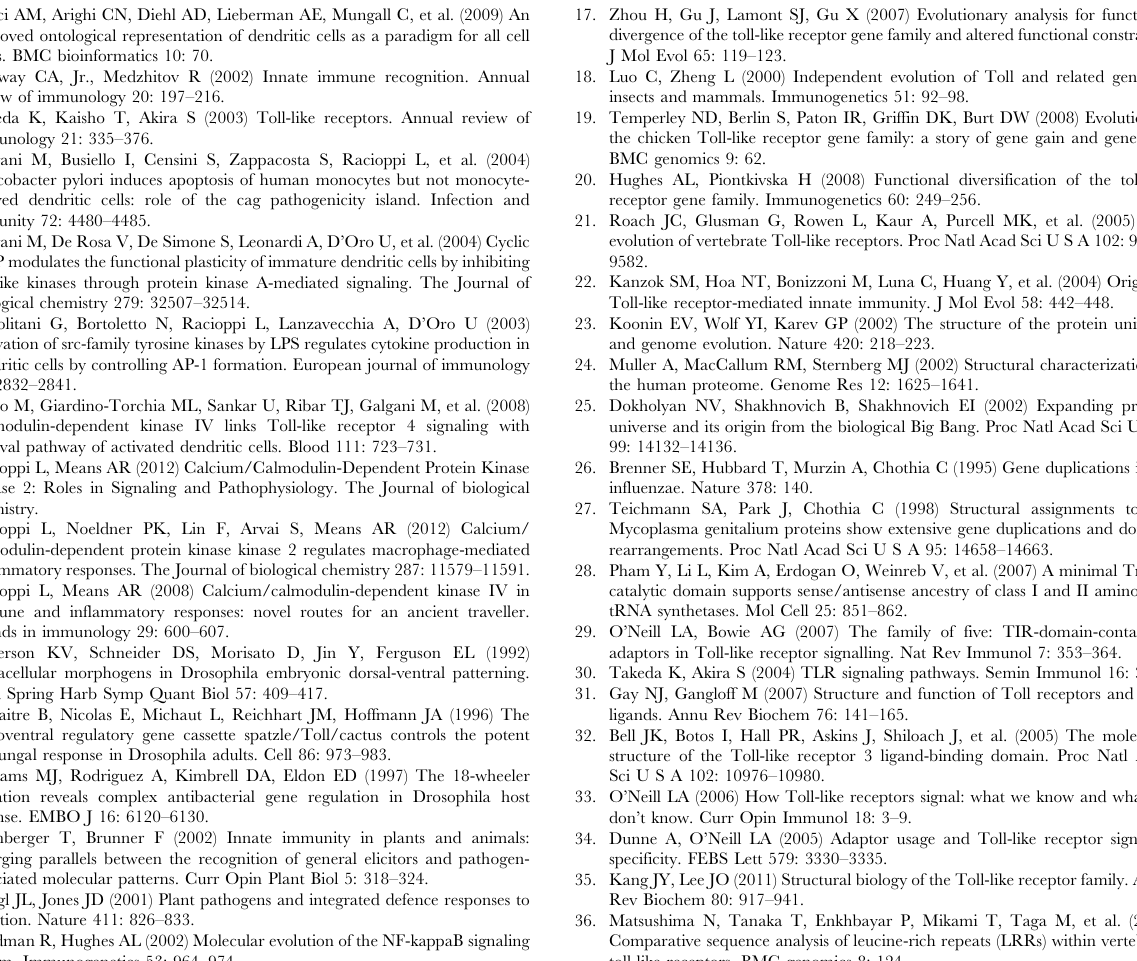
sequence. The tree is rooted by the outgroup Nicotiana glutinosa N. The numbers indicate boot-strap support out of 1000. Only value above 500 are indicated. (TIFF) Figure S6 Minimum evolution phylogeny of the TIR domain of the TLR adaptor molecules alone. The tree is rooted by the outgroup TIR domain Homo sapiens TLR5. The numbers indicate boot-strap support out of 1000. Only value above 500 are indicated. (TIFF)